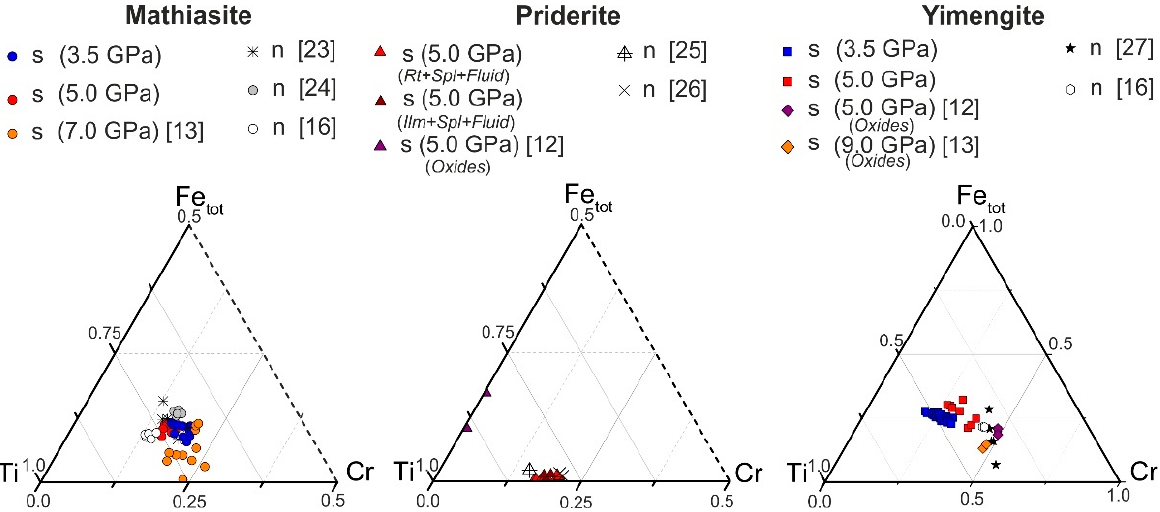
Figure 4. Ti–Fe–Cr diagram (apfu) illustrating compositional variations of synthetic mathiasite, priderite and yimengite. n—natural; s—synthetic.